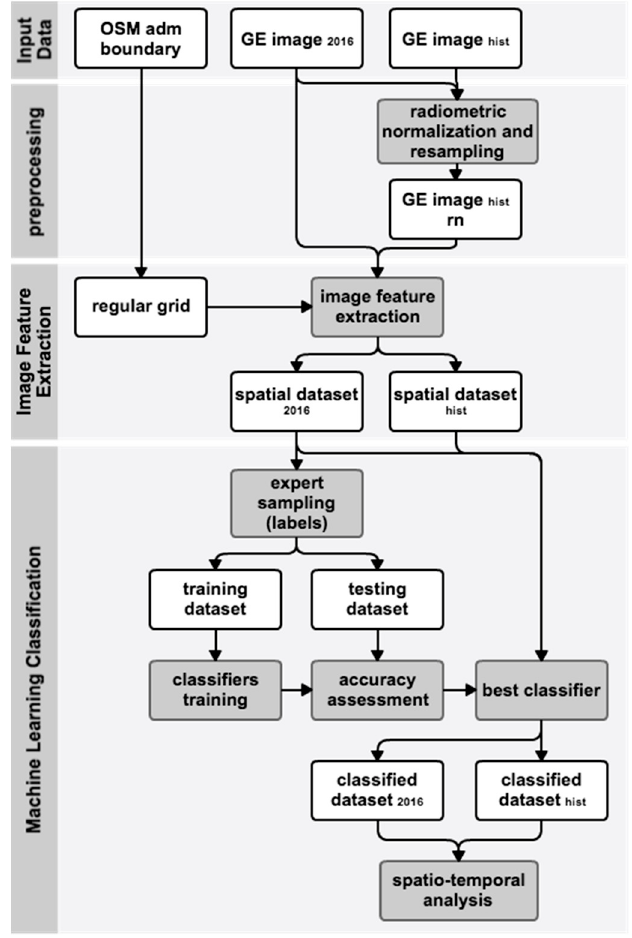
Figure 1. Flow diagram of the proposed approach for slum detection and change analysis.